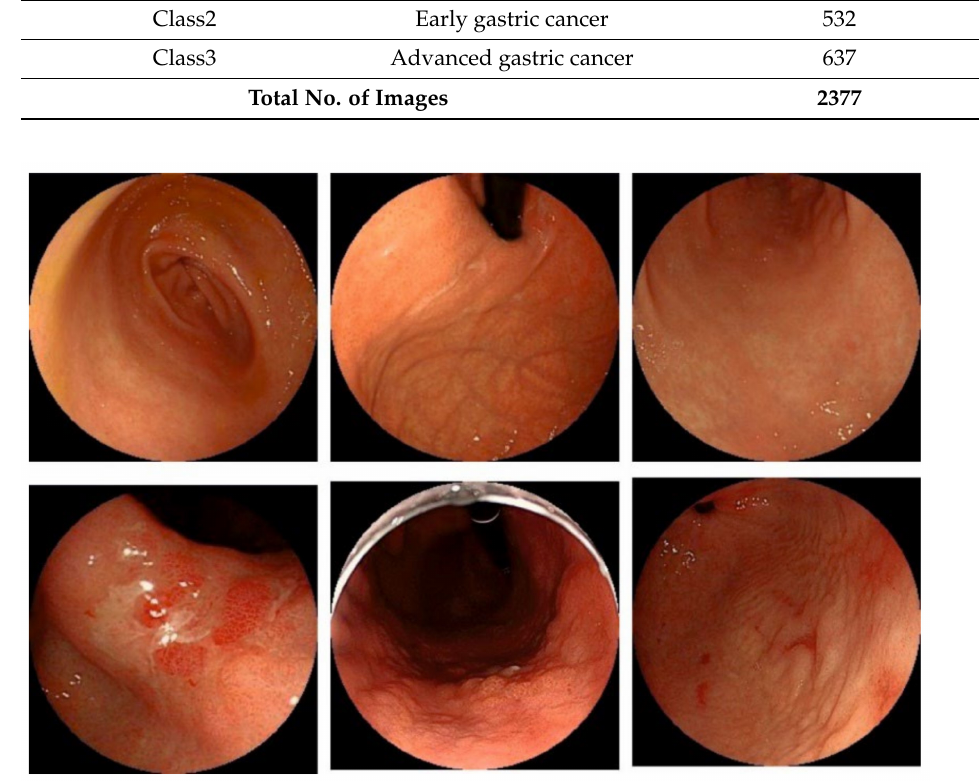
Figure 3. Sample